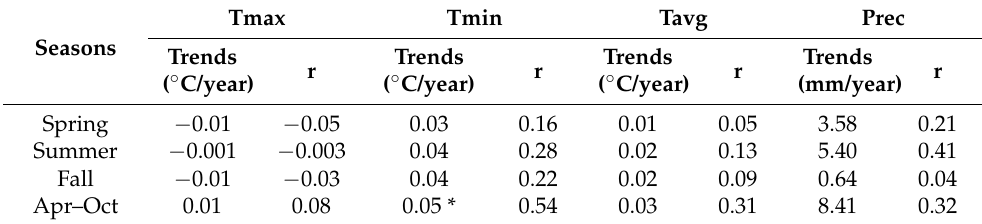
Table 3. Trends of seasonal climatic factors in Kentucky, 2000–2018.